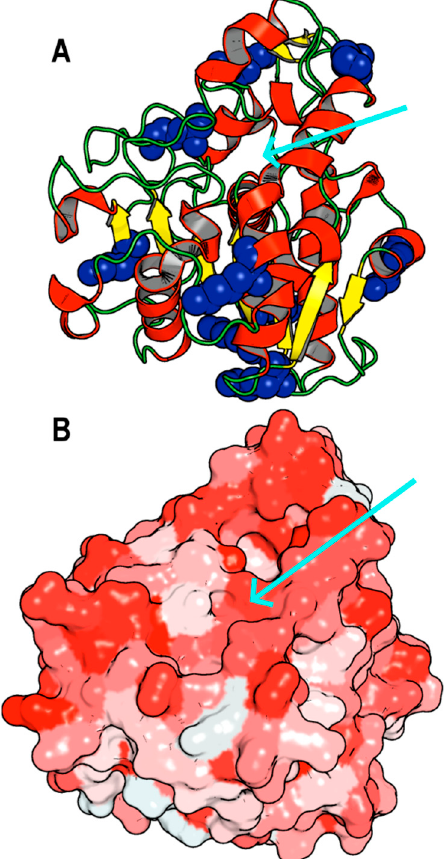
Figure 6. Analysis of the 3D structure of lipase B from Candida antarctica (CaLB, PDB: 1TCA). ( A ) The active site entrance is indicated by a cyan arrow while the superficial Lys are highlighted in blue spheres on the secondary structure of the enzyme. ( B ) The color of designates the hydrophobicity of the surface, going from white (hydrophilic) to red (hydrophobic).